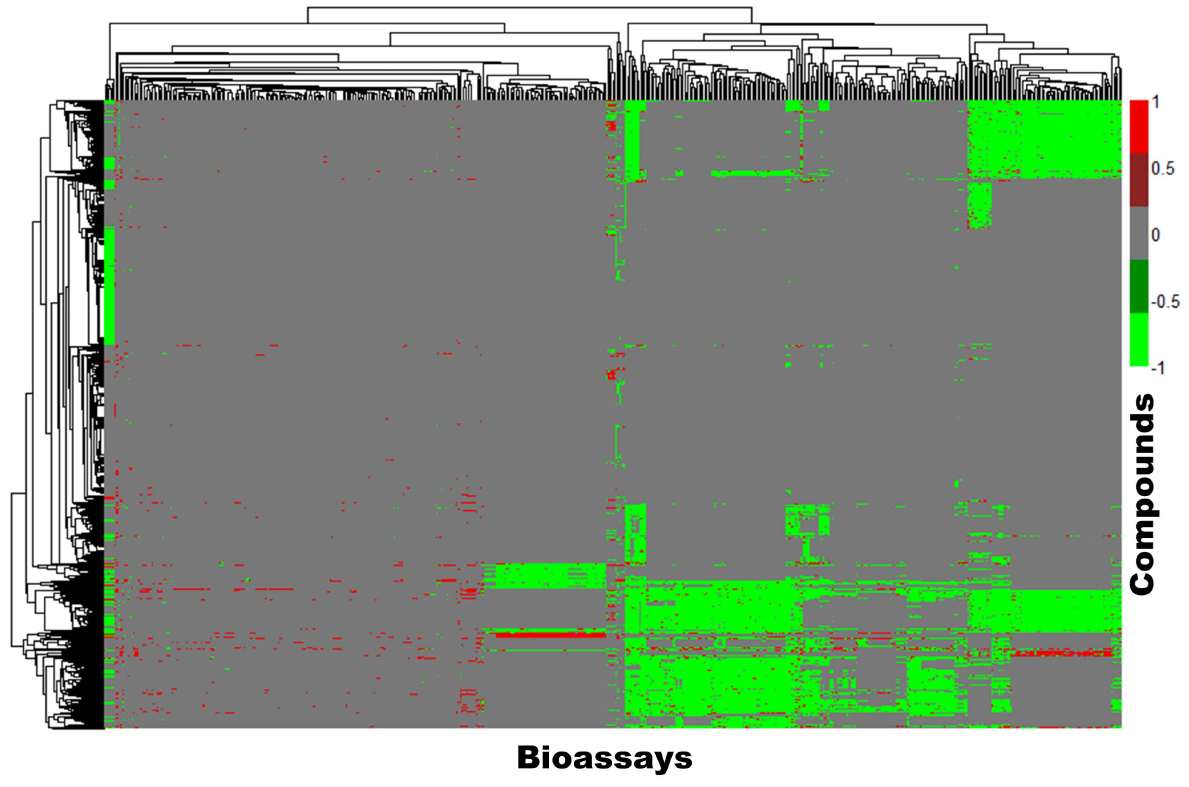
Figure 2. The heat map for the response profiles of 1,899 compounds against 555 bioassays. The red dot (Value=1) indicates the compound has an active response in the corresponding bioassay. The light green dot (Value= 2 1) indicates the compound has an inactive response in the corresponding bioassay. The grey dot (Value=0) indicates the compound is untested or has inconclusive results in the corresponding bioassay.